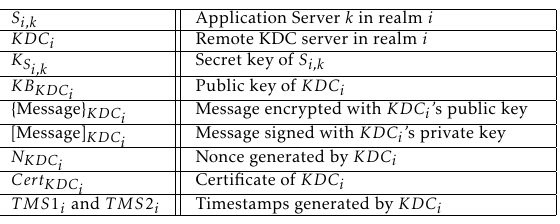
Table 6. The Operations of Encryption and Decryption When n Application Servers are in m Remote